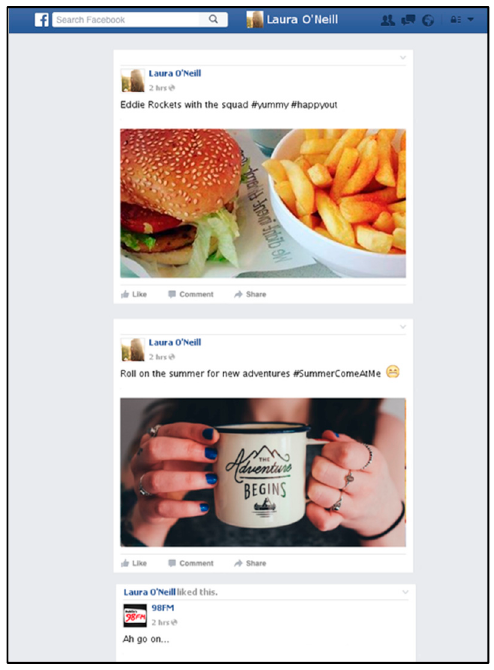
Figure 1. An example of a profile news feed image. The first post (burger and fries) is the target advertising post (in this case, unhealthy food advertisement, shared by a peer); the second and third are generic distractor posts.